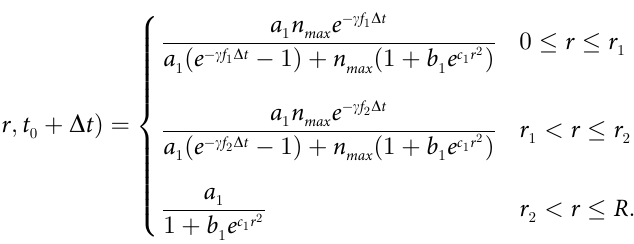
behavior is important to incorporate because the vast majority of tumours exhibit some form of treatment resistance. This resistance is conferred to a tumour through heterogeneities of various traits across its volume, such as cell-type, phenotypic expression, and stem-ness. Of particular interest to radiation therapy, tumour hypoxia is a prominent feature that leads to increased radioresistance. As we will see, inclusion of logistic cytotoxic action reproduces this behavior and dramatically changes the results. We note that this is a purely phenomenological effect and not meant to describe the underlying biology at play. We make the same simplifica- tions as before leading to the piecewise equivalent to Eq (5),